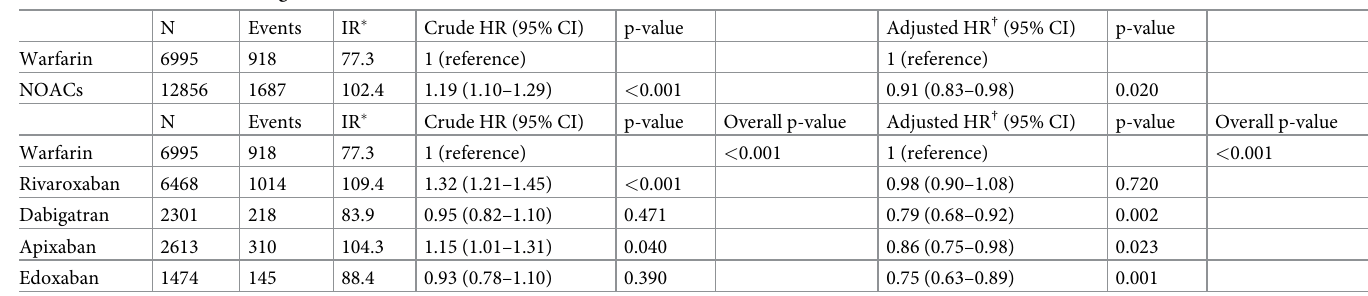
Table 3. Risk of death according to OAC